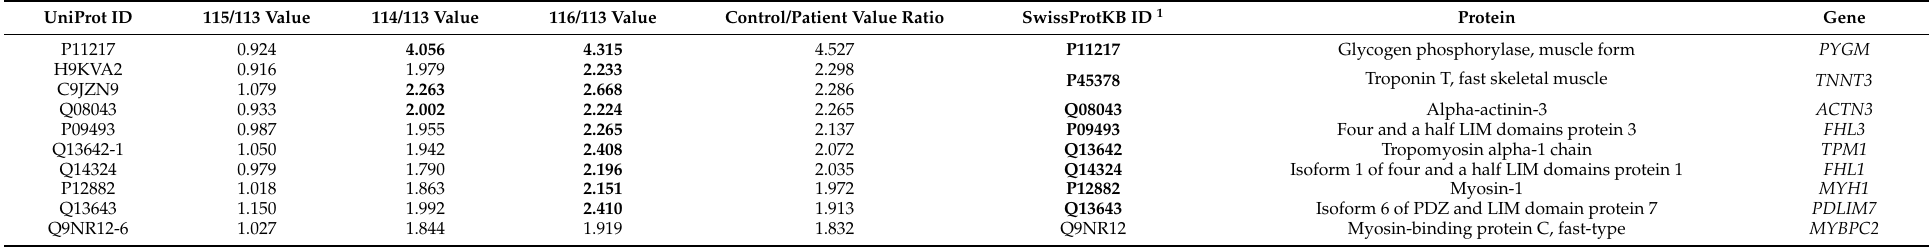
Table 4. Most differentially expressed muscle proteins in GSDV vs.